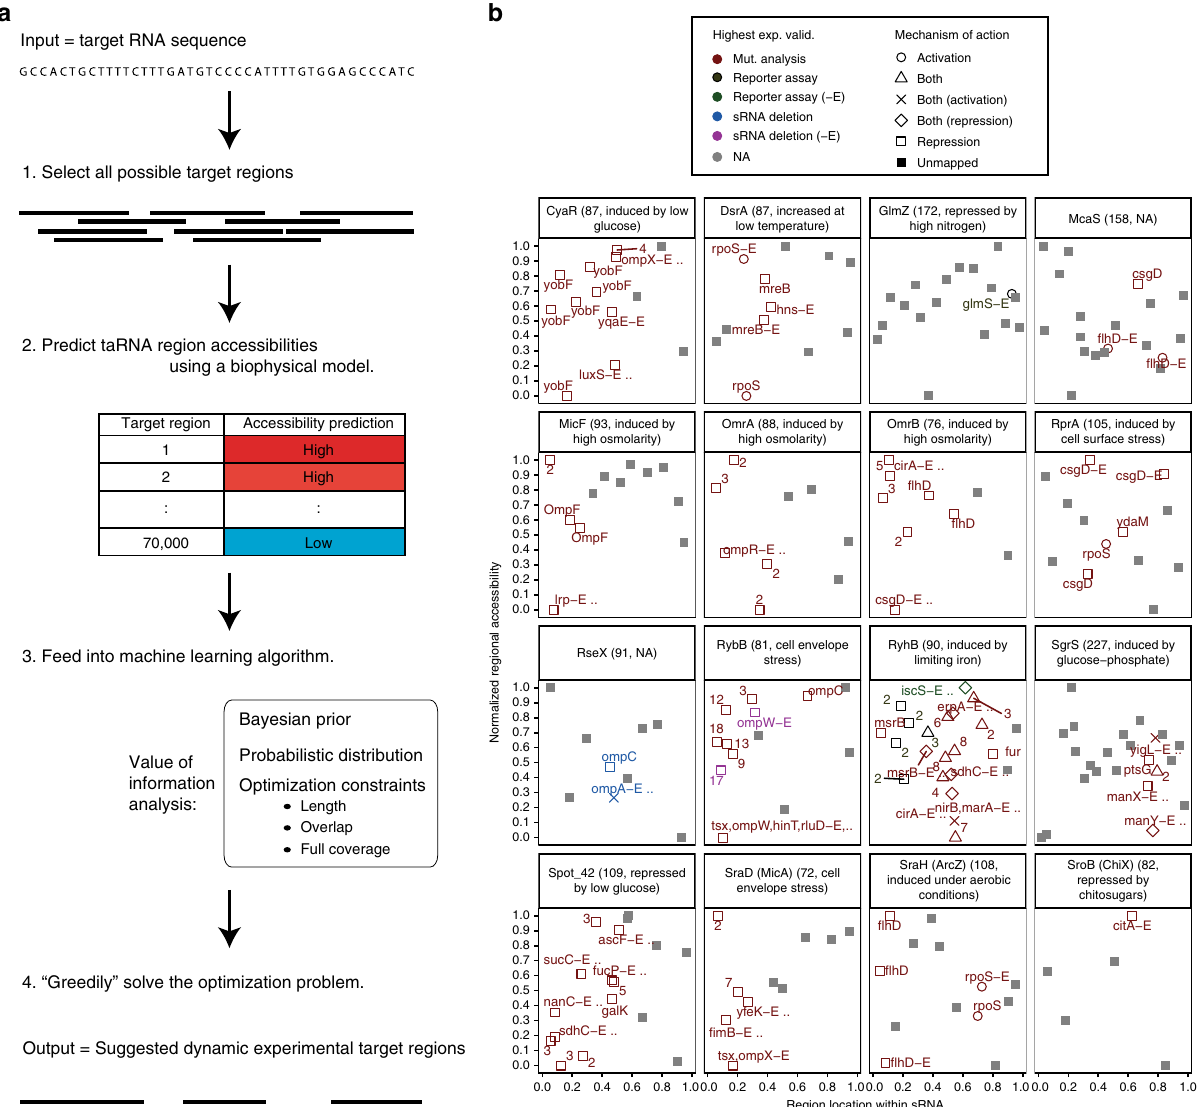
Fig. 3 INTERFACE investigation supports identi fi cation of binding site features in an ensemble of native sRNAs. a Work fl ow for machine-learning algorithm to select for accessible interfaces. Machine-learning methodologies modi fi ed for batch use were coupled to a biophysical model to select for potentially accessible regions, a consideration previously shown important to successful interactions 12, 28 , in a large ensemble of E . coli sRNAs. Given RNA sequence only, the biophysical model predicts the accessibility of all possible regions. Regions of interest are selected via the machine learning algorithm, based on value of information analysis, to minimize experimental effort and meet speci fi ed optimization constraints. b The accessibility of all regions evaluated via INTERFACE, both chosen by the machine learning algorithm and deliberately designed to target previously mapped exact binding sites, are shown with respect to sRNA location for the pool of 16 well-characterized sRNAs within the ensemble (length and known stress response are indicated in the title). “ -E ” is listed following regions corresponding to exact mapped mRNA-binding sites that make up our exact binding site training set. The names of target mRNAs are listed beside regions that are fully contained within known binding sites (and, in the case of multiple targets, numbers corresponding to the number of mRNAs known to establish base pairs with said region). Exact binding site mRNA labels are followed by “ .. ” if the region is also fully contained within other experimentally con fi rmed interactions (Supplementary Data 1). Interestingly, exact mapped binding sites tend toward the extreme thirds of accessibility and tend away from extreme 3 ′ positions — interactions past the fi rst 80% of the sequence are only seen in sRNAs GlmZ, RprA, and McaS. Colors indicate the highest experimental validation (ranked as: mutational analysis, reporter assay, sRNA deletion). Shapes indicate the mechanism of sRNA regulation of mRNA expression. In the case that a region contains binding segments for multiple mRNAs, the mechanism corresponding to an exact mapped binding site is listed ( “ -E ” in